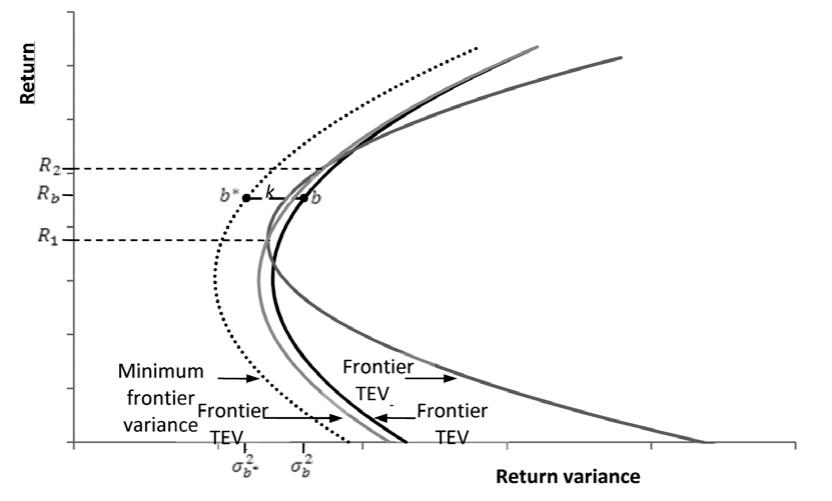
Fig. 1. The minimum variance frontier and various TEV